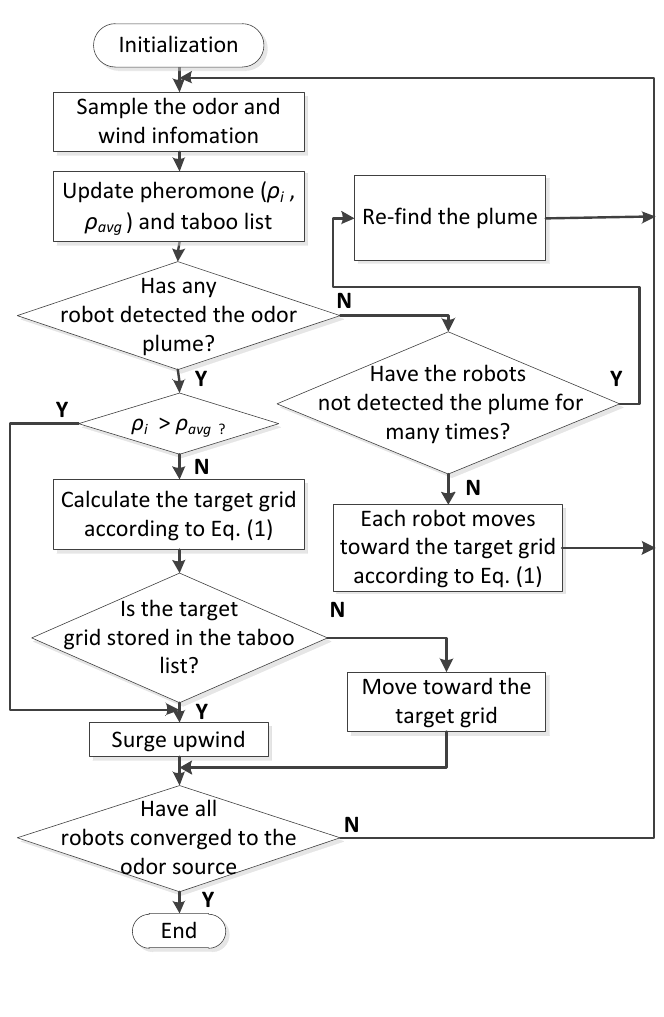
Figure 2. The flowchart of the proposed AACO+US algorithm. The variables ρ stand for the virtual pheromone in the i th grid and the average pheromone,